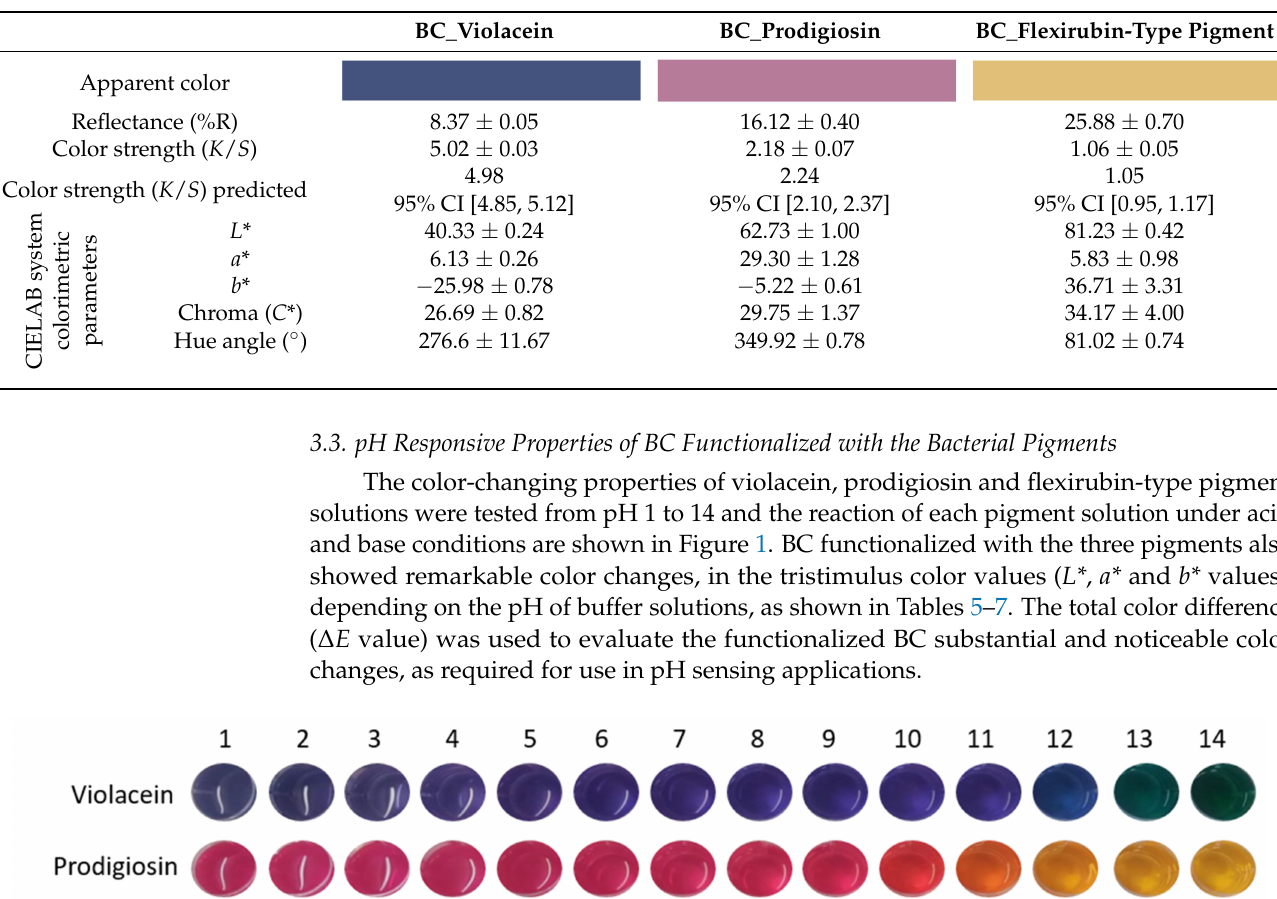
Table 4. Apparent color, reflectance, color strength ( K / S ), and colorimetric parameters of BC function- alized with violacein, prodigiosin, and flexirubin-type pigment, as well as the K / S values, predicted with each regression model and the confidence intervals with 95% of significance.